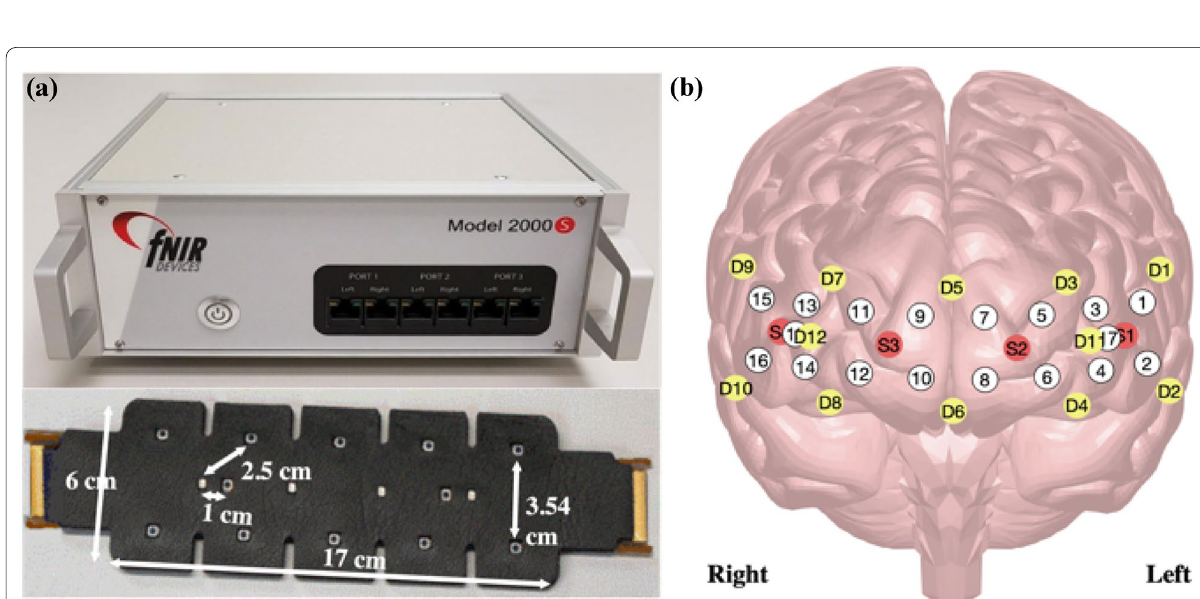
Fig. 2 Functional near-infrared spectroscopy system used to collect relative changes in oxyhemoglobin and deoxyhemoglobin concentrations. A The data acquisition and sensor used. The sensor allowed for measurement of cerebral and extracerebral activities using long (2.5 cm) and short (1 cm) source detector separation (SDS) channels. B The location of sources or light emitting diodes (red circles), detectors or photodiodes (yellow circles), and channels (white circles) on the prefrontal cortex. Channels 1 through 16 represent cerebral measurements, while channels 17 and 18 represent extracerebral